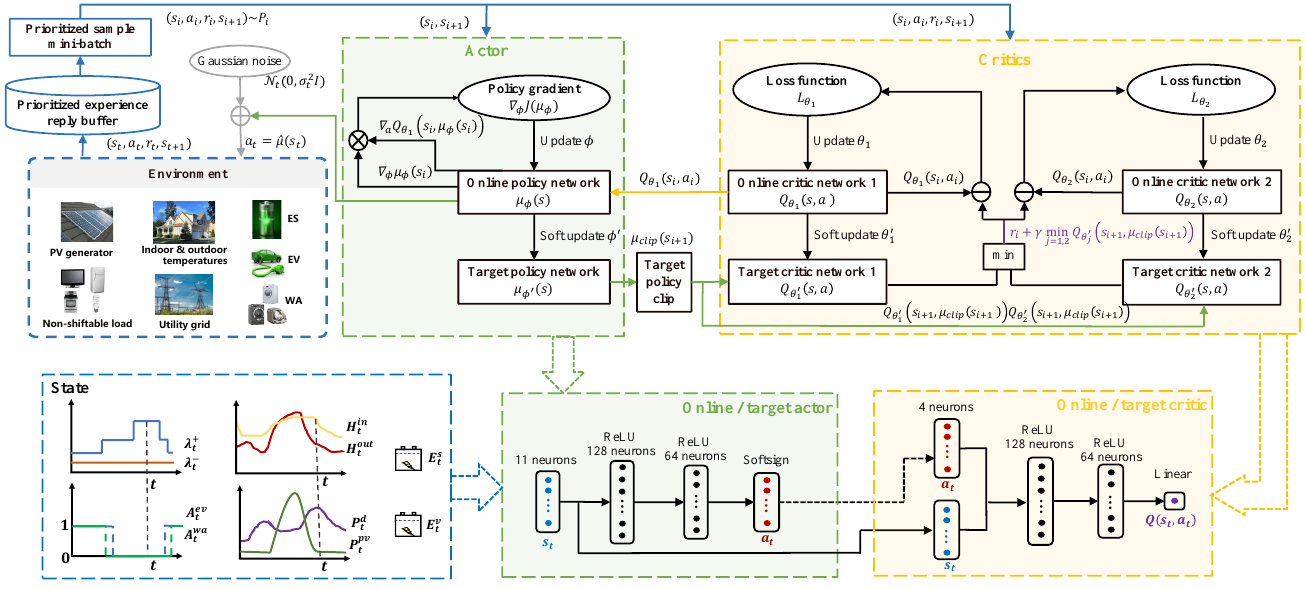
Figure 3. Overall workflow of the proposed TD3-based DR management